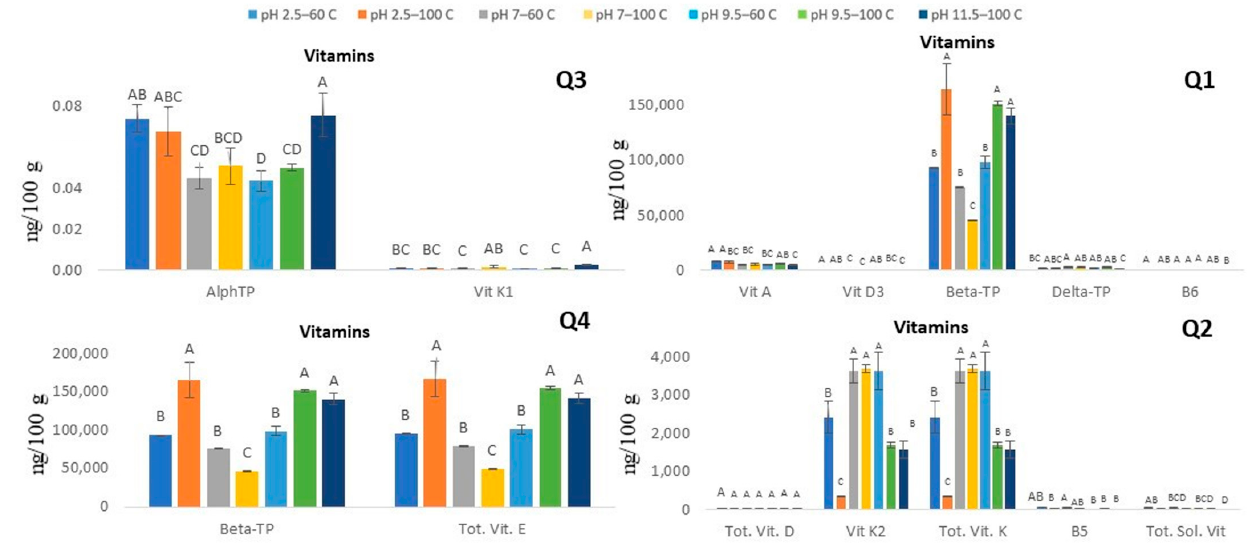
Figure 4. Vitamin contents in Inonotus obliquus samples extracted under different combinations of pH (2.5, 7, 9.5, 11.5) and temperatures (60 °C and 100 °C). Bars represent means of four replicates ± standard errors. Values accompanied by the same letters are not significantly different ( p < 0.05), Fisher’s LSD test.